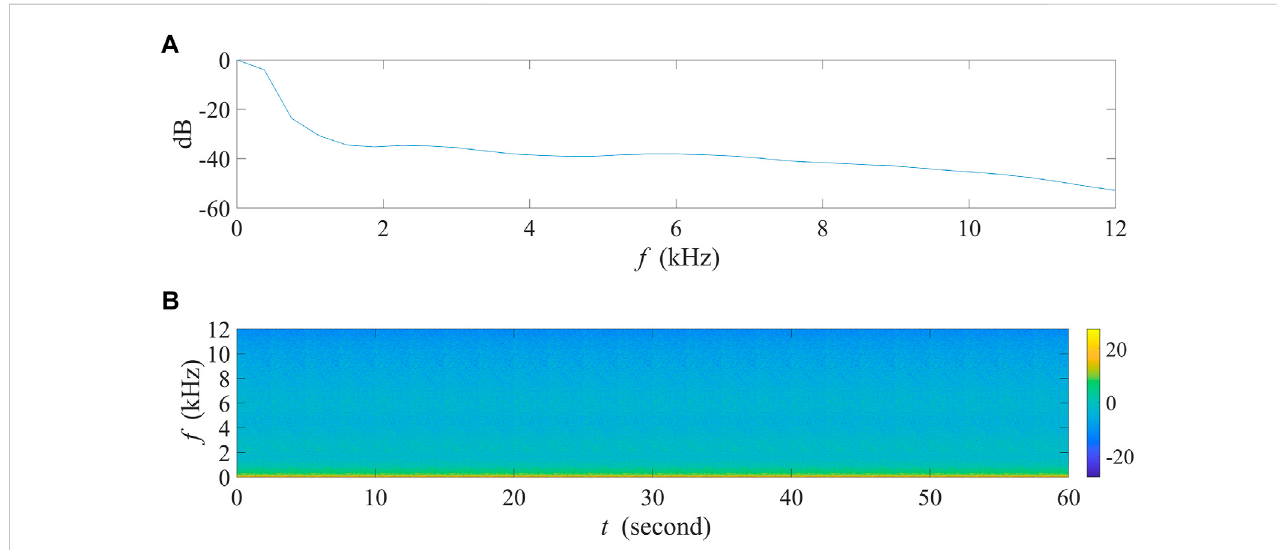
FIGURE 3 The1-minbackgroundnoiserecordingcollectedatsiteAinJiuliLakeNationalWetlandPark,Xuzhou,JiangsuProvince,China. (A) Thenormalizedpower spectrum of the recording. (B) The spectrogram of the